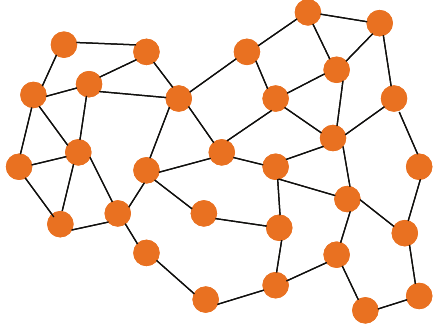
Figure 1: Conventional wireless